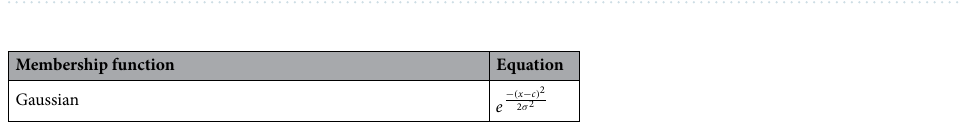
Figure 9. The temperature distribution for different inlet temperatures versus the turbulent kinetic energy and the dimensionless positions of the nodes.